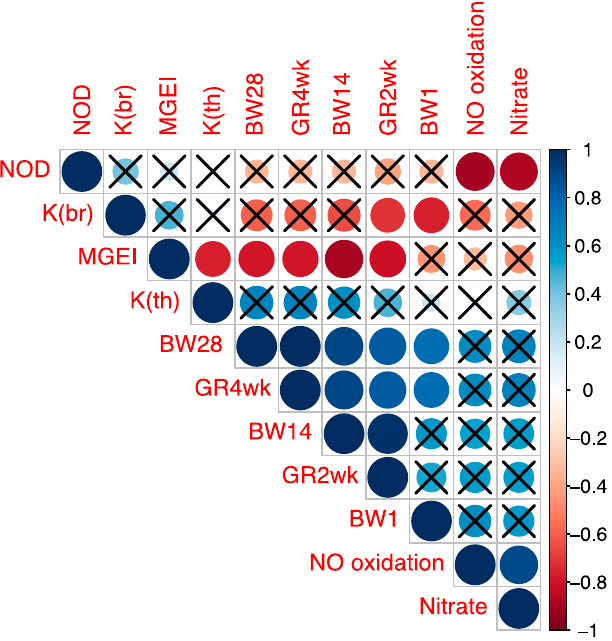
Figure 3. Spearman’s correlation coefficients between the studied indicators. Abbreviations: BW1, BW14 и BW28, body weight at 1, 14 and 28 days; GR2wk and GR4wk, growth rate for 2 and 4 weeks; NOD, content of NO donors; Nitrate, content of nitrate; NO oxidation, rate of NO oxidation to nitrate; K (br), K coefficient in the breast muscles; K (th), K coefficient in the thigh muscles; MGEI, myogenesis gene expression index expressed as the ratio K (br)/ K (th). Significant correlations are not crossed out with the sign « × » ( p < 0.05).